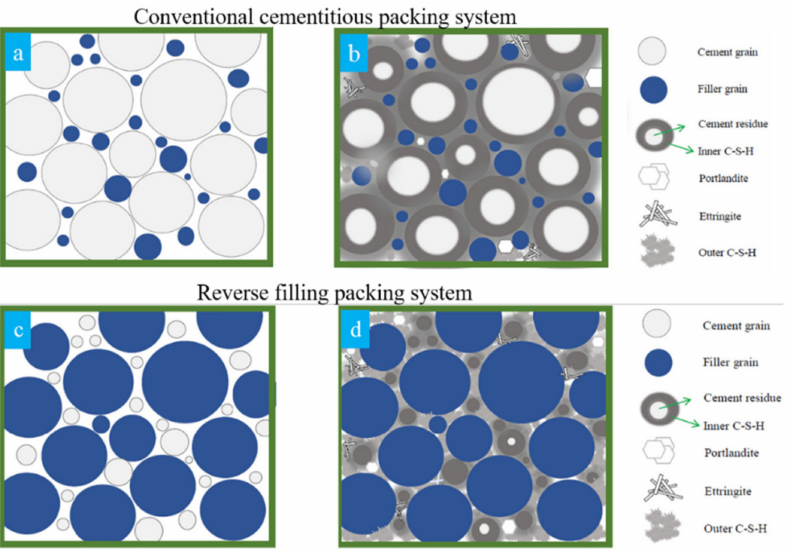
Figure 1. Schematically comparison of packing system between conventional cementitious system and reverse filling system ( a , c ) before and ( b , d ) after hydration, from